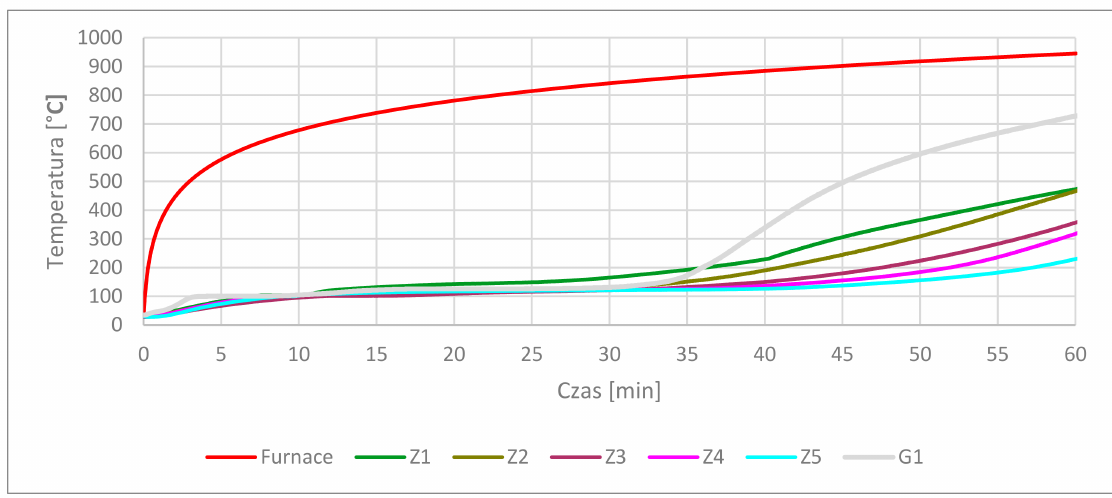
Figure 4. Core temperature results. Table 6. Elongation time in comparison of cement core temperature increase in 100–150 ◦ C interval. Samples Time [min]